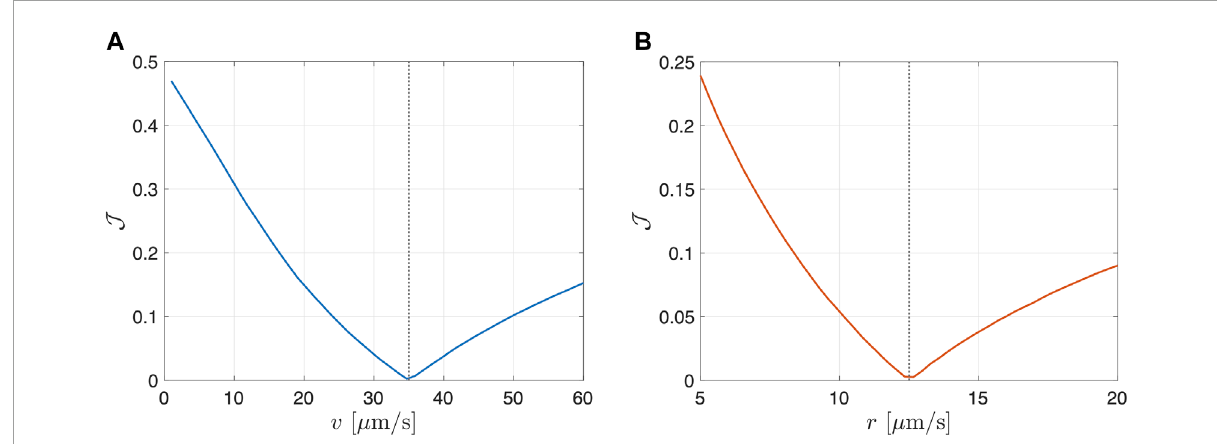
FIGURE 3 (A) Discrepancy functional J ( υ , r ) evaluated on a 50-point discretization of I υ for r = 12 . 5. (B) Discrepancy functional J ( υ , r ) evaluated on a 50-point discretization of I r for υ =